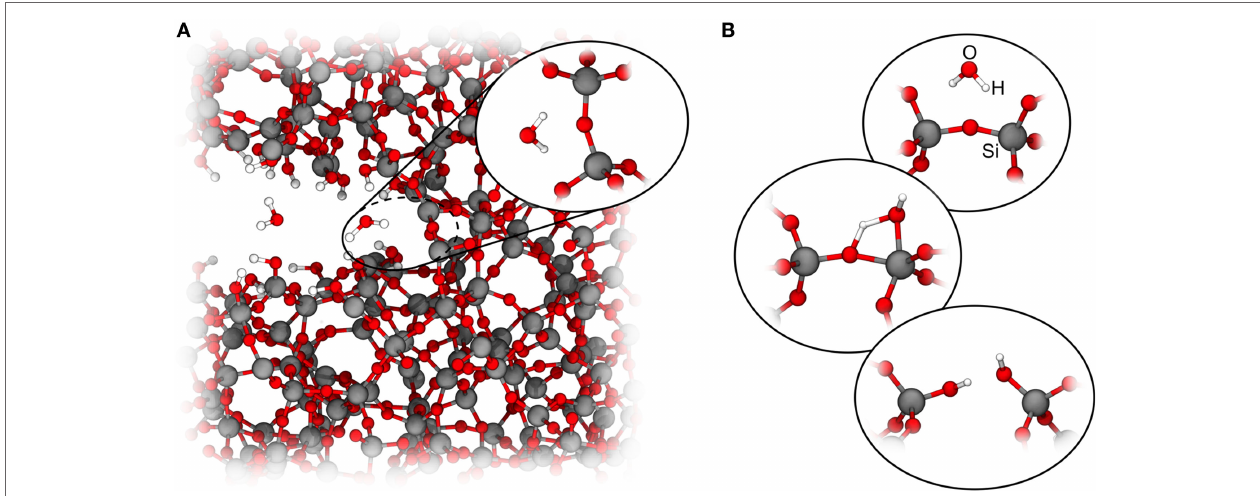
FIGURE 1 | Reactive crack propagation in silica. (A) Atomistic view of a crack tip in silica glass; (B) subcritical crack growth mechanism (Michalske and Freiman, 1982). In the vicinity of the crack tip, one or more water molecules adsorb at a stressed Si–O–Si linkage (I), the Si–O bond is cleaved via a transition structure (II) and finally converted to surface silanol groups